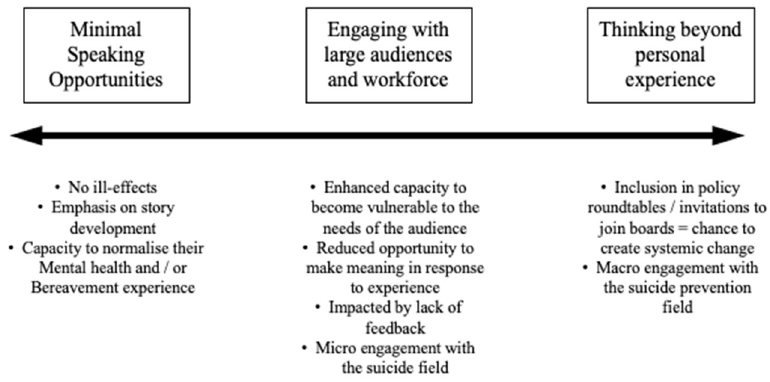
Figure 1. A developmental continuum: identification of experiences.